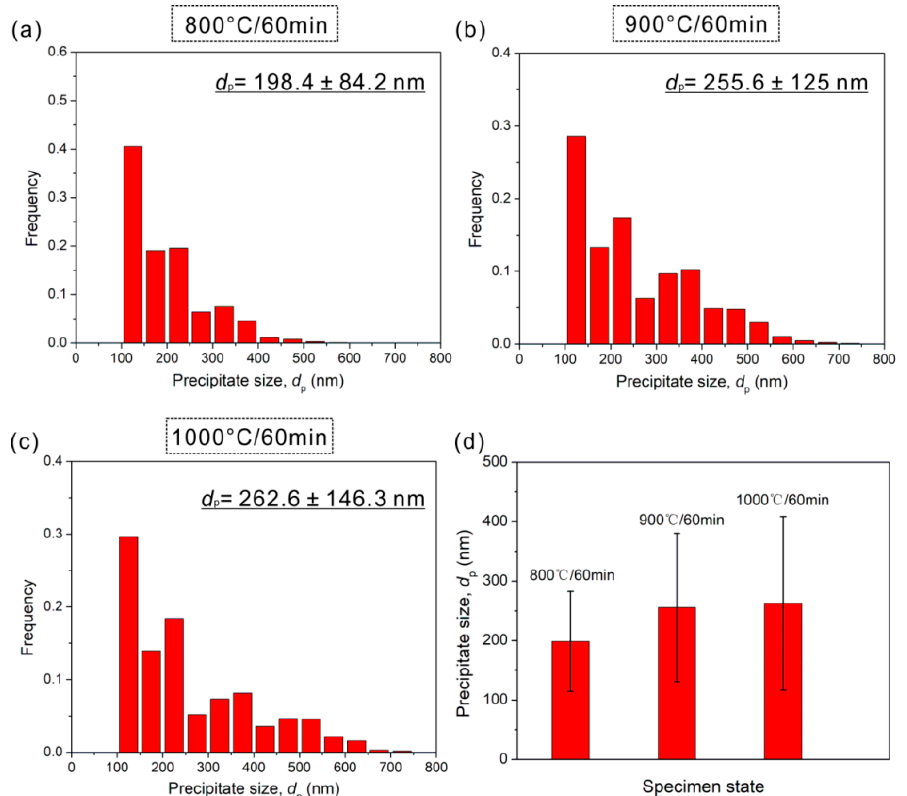
Figure 7. The histograms of precipitate size distribution in HEAs annealed at ( a ) 800 °C, ( b ) 900 °C, and ( c ) 1000 °C; ( d ) precipitate size as a function of annealing temperature.